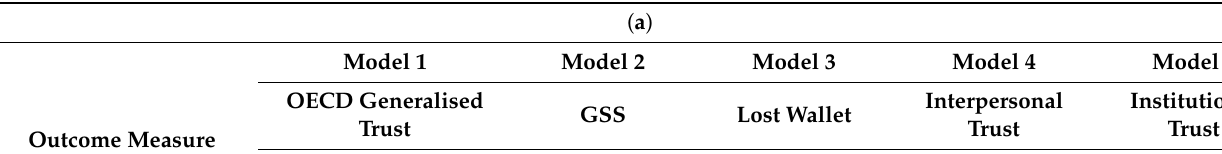
Figure A1. ( a ) Trust versus Trustworthiness ( b ) Expected Trustworthiness. Table A5. ( a ) Regression analysis of Trust without economic and other regarding preferences. ( b ) Regression analysis of Trustworthiness without economic and other regarding preferences. ( c ) Regression Analysis with Residual Experimental Trust. ( d ) Regression Analysis controlling for country fixed effects.